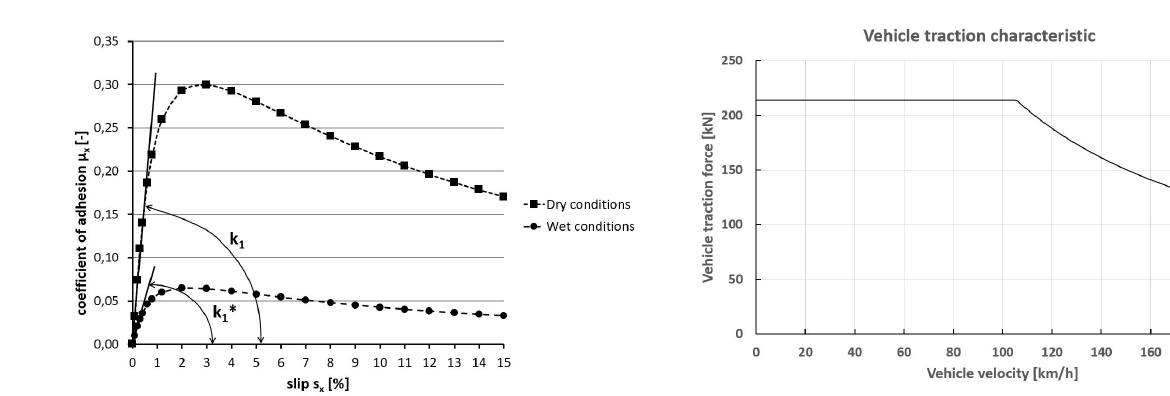
Figure 6. Popovici’s adhesion characteristics [7].